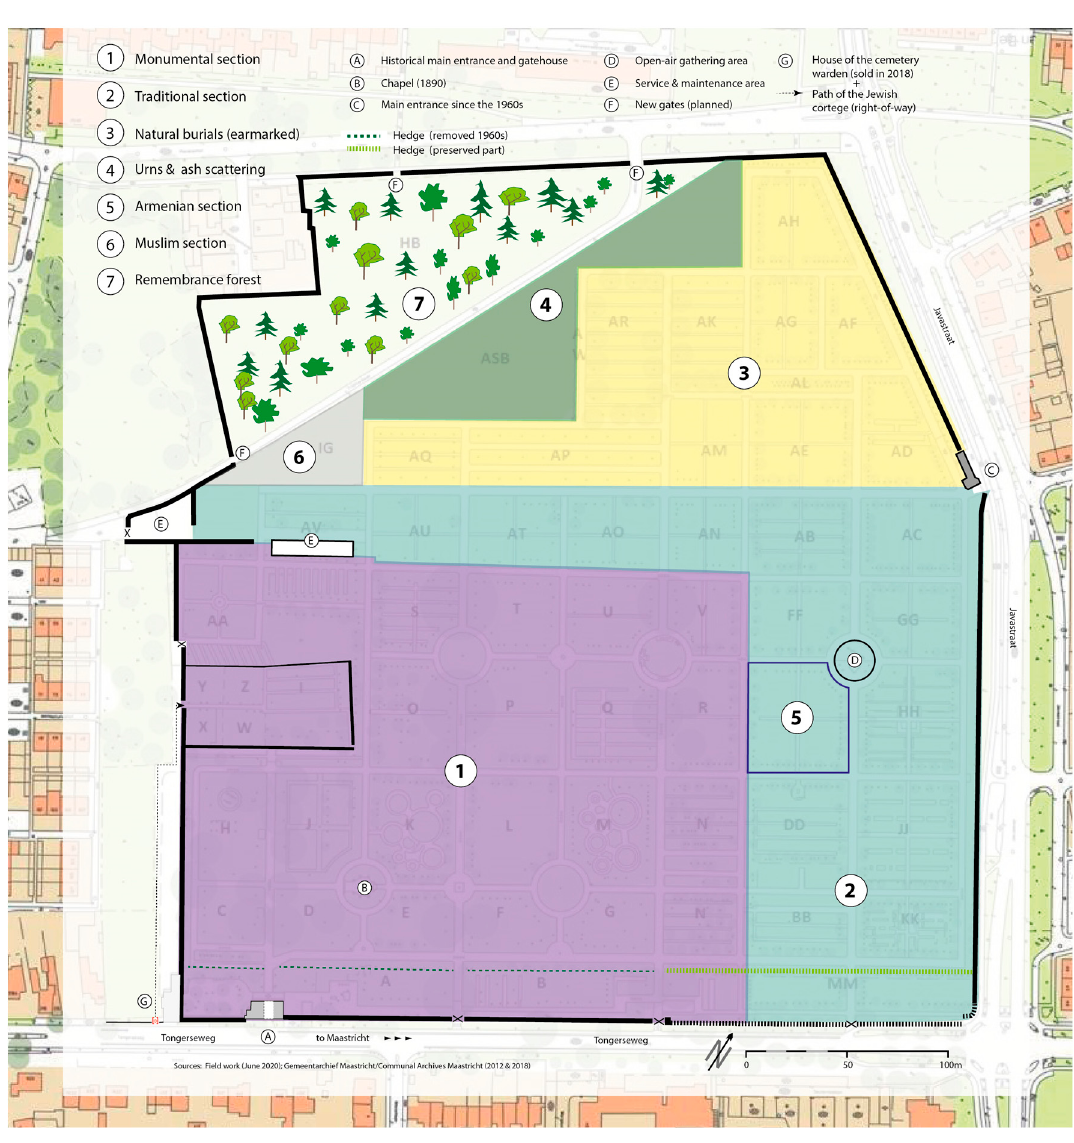
Figure 8. Future plan of Cemetery Tongerseweg, dividing the cemetery into multiple parts. (1) is the “traditional” part, where monumental graves can be spotted; this part will remain as it is today. Part (2) will be slightly altered to include grave sections for different communities, in particular the new Armenian grave field (5). Part (3) will be redesigned and is earmarked for urns. Part (4) will offer provisions for ash disposal. Part (6) accommodates new Islamic burials. Part (7) is an important extension, intended for a memorial forest. (T.K.).